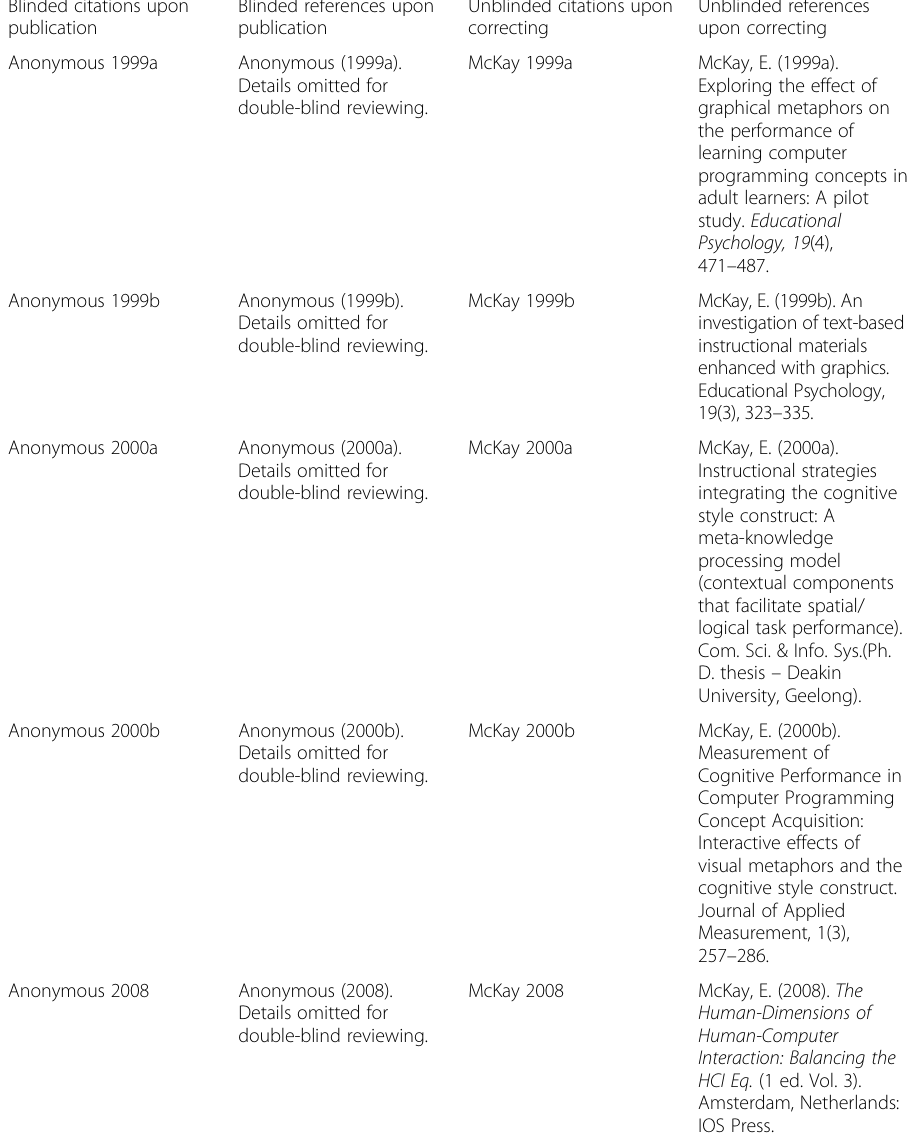
Fig. 12 Cognitive performance of ICS groups with T1 and T2 (Mohamad, 2012 p.177) This figure shows the results in a graphical representation of the interactive nature of the cognitive performance of integrated cognitive style (ICS) wholist-verbaliser, wholist-imager, analytic- verbaliser, analytic-imager for the two instructional treatments: T1 (text-plus-textual metaphor) and T2 (text-plus-graphical format) based on average